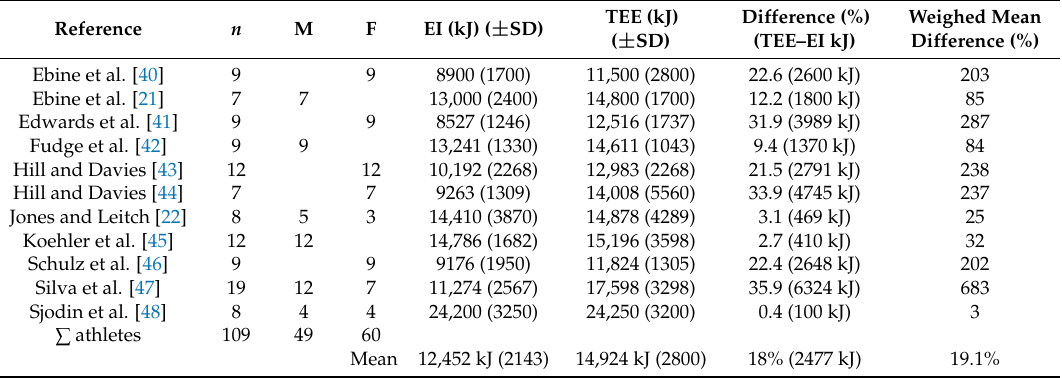
Table 3. Calculation of weighted mean difference between reported EI and TEE measured by DLW